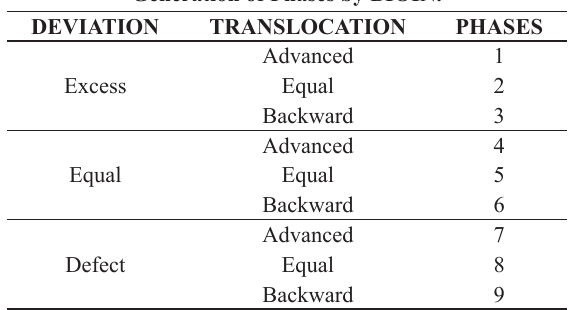
Generation of Phases by